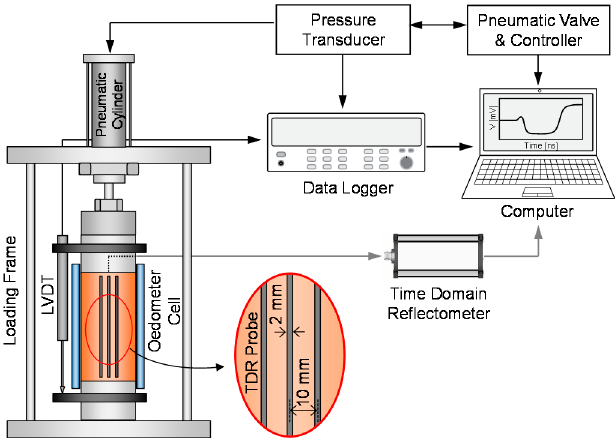
Figure 2. Schematic drawing of repetitive loading system. Linear variable displacement transducer (LVDT) and time-domain reflectometry (TDR) denote linear variable displacement transducer and time domain reflectometry, respectively.